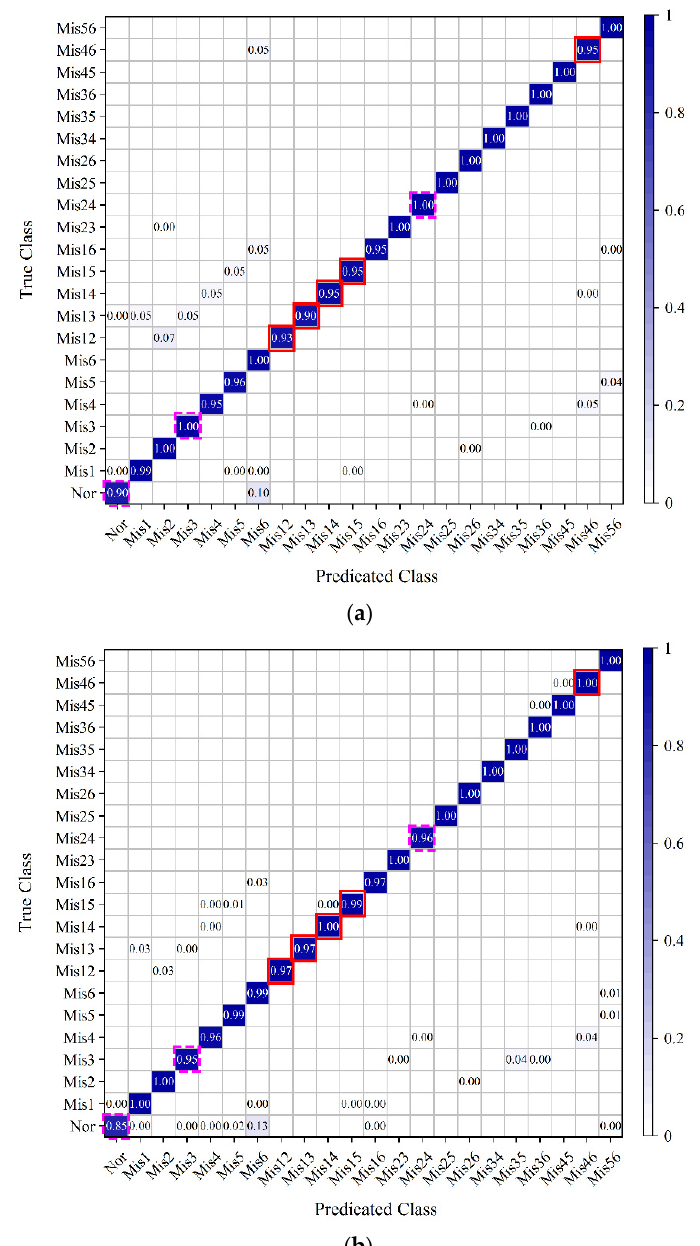
Figure 18. Training and testing results by using the third network and data division mode 2_d. ( a ) Training result. Total accuracy is 97.40%. ( b ) Testing result. Total accuracy is 98.12%. The red boxes mark the accuracies that increase more than 4%. The magenta boxes mark the accuracies that de- crease more than 4%.